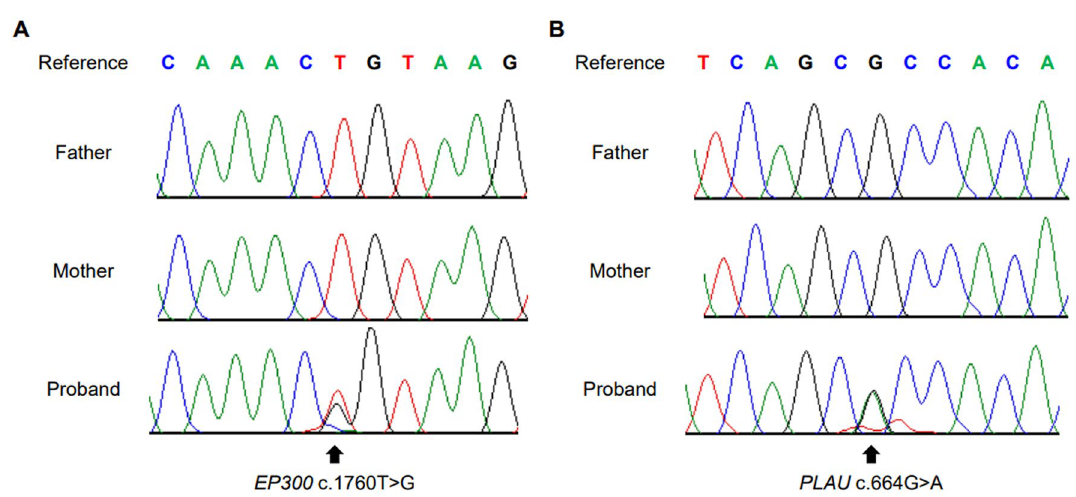
Figure 5. Electropherograms of EP300 and PLAU obtained using Sanger sequencing. Two heterozygous missense variants in EP300 ( A ) and PLAU ( B ) were identified as de novo